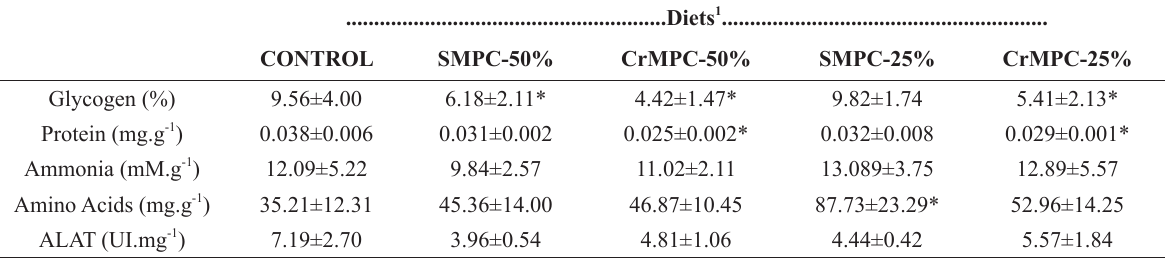
Hepatic biochemistry values for silver catfish of different experimental groups fed different experimental